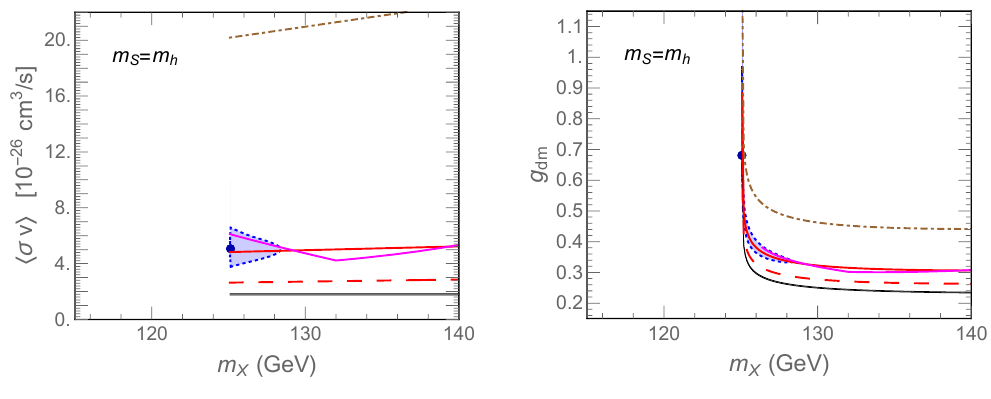
Figure 7 . Same as (cid:12)gure 6 but for m S = m h